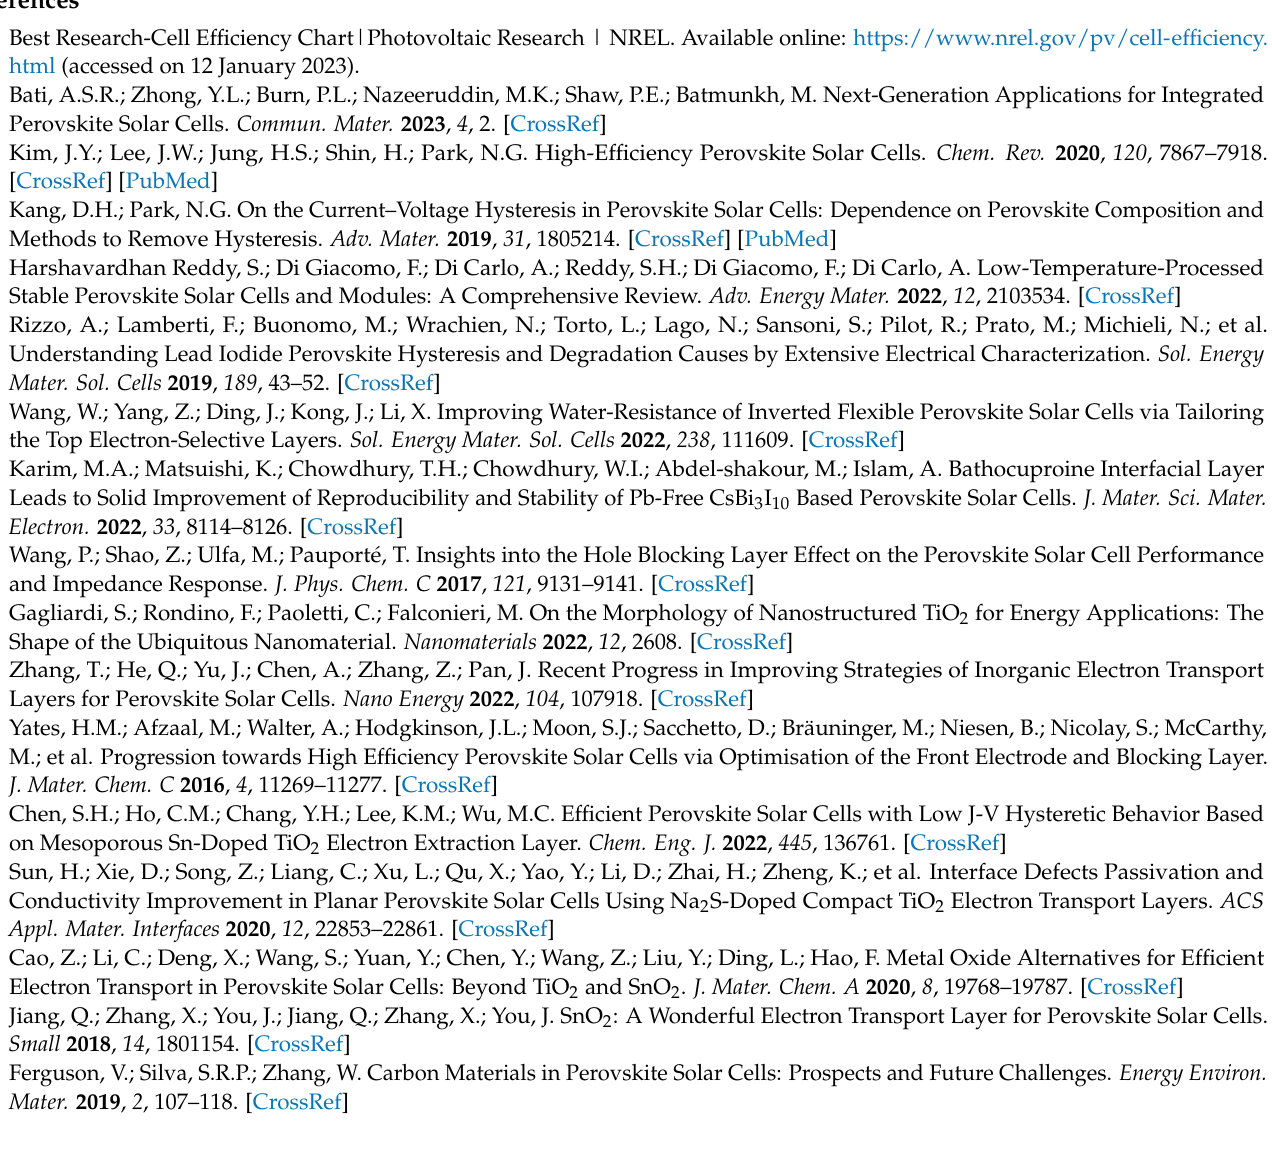
Figure S2: Normalized short-circuit current; Figure S3: Normalized open-circuit voltage; Figure S4: Normalized fill-factor; Figure S5: Normalized power conversion